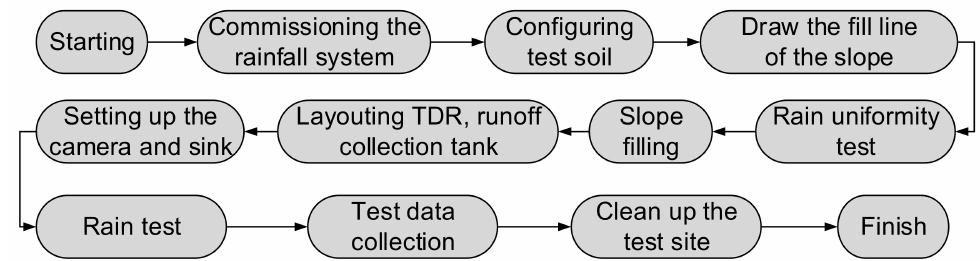
Figure 5. Flow chart of the slope rainfall test.